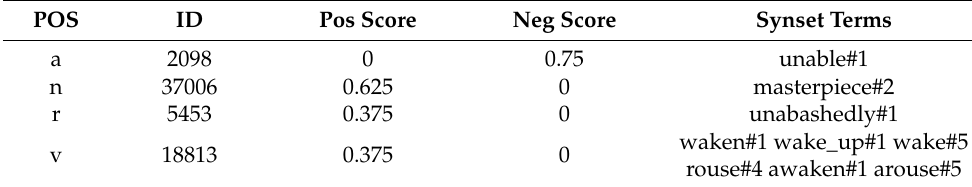
Table 2. A sample from the lexical resource named SWN.